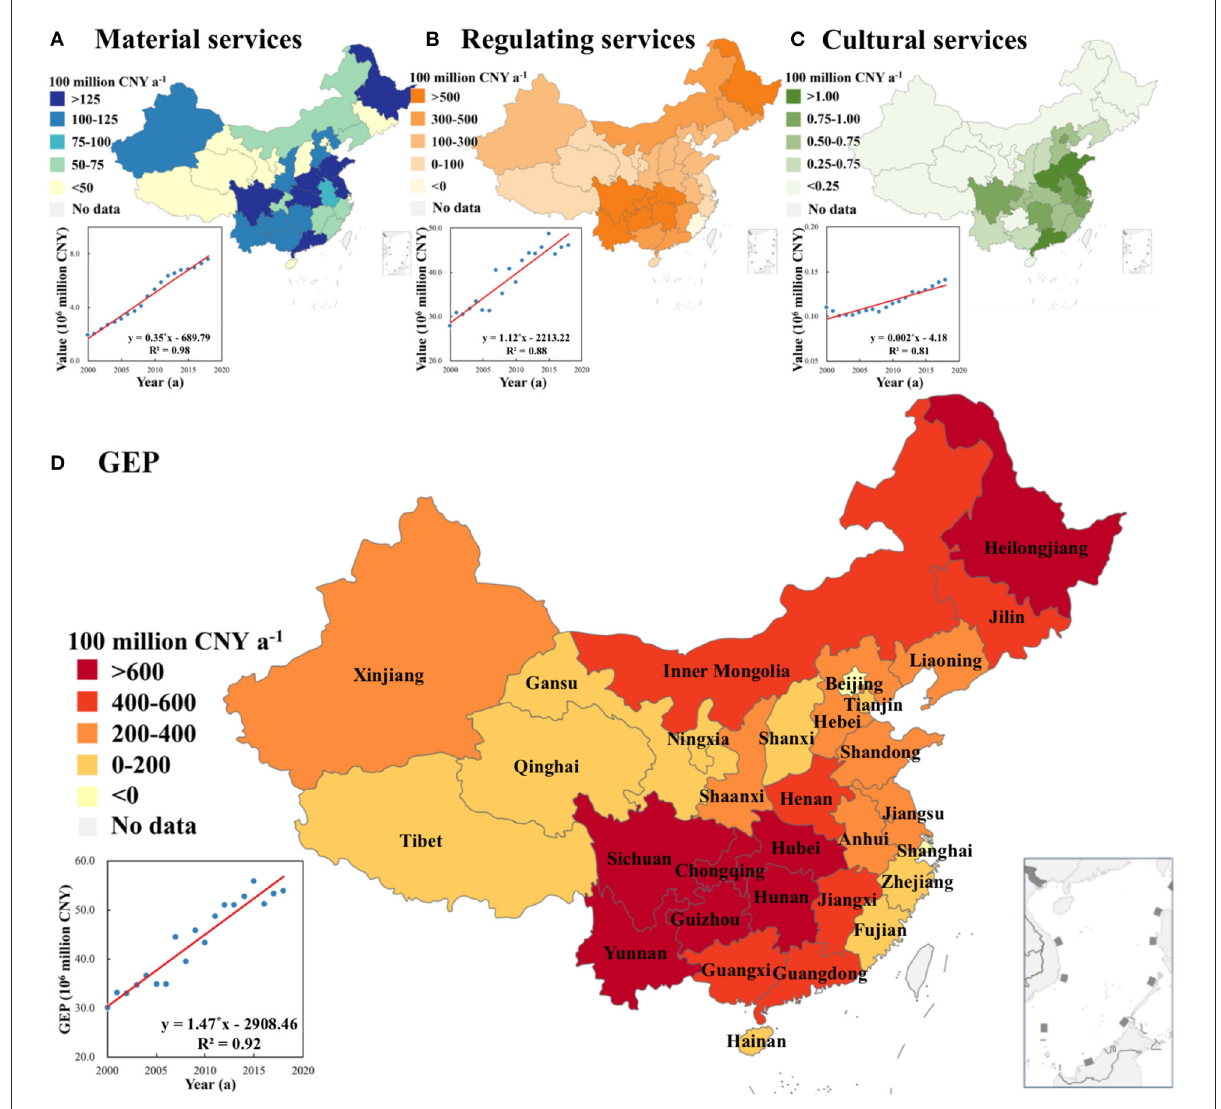
FIGURE2 Temporal patterns of cropland ecosystem services in China during 2001–2019. (A–C) Temporal patterns of the growth rates of the material, regulating, and cultural services; (D) Temporal pattern of the growth rates of gross ecosystem product (GEP). The scatterplot is the linear regression of each service’s value over time in